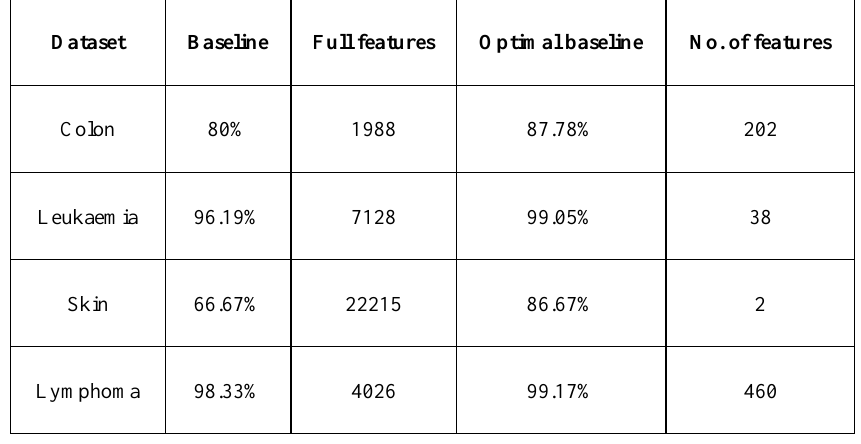
Table 2. The baseline using full features and the optimal baseline with the number of